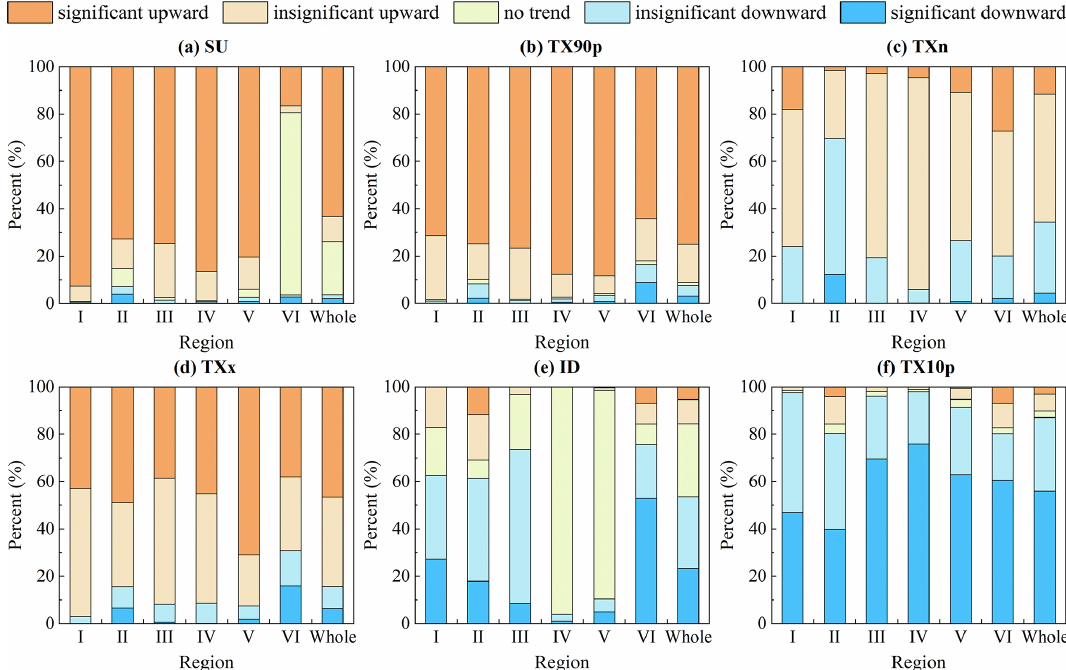
Figure 17. Area percentage of the trend of extreme temperature indices in different regions of China during 1979–2018.